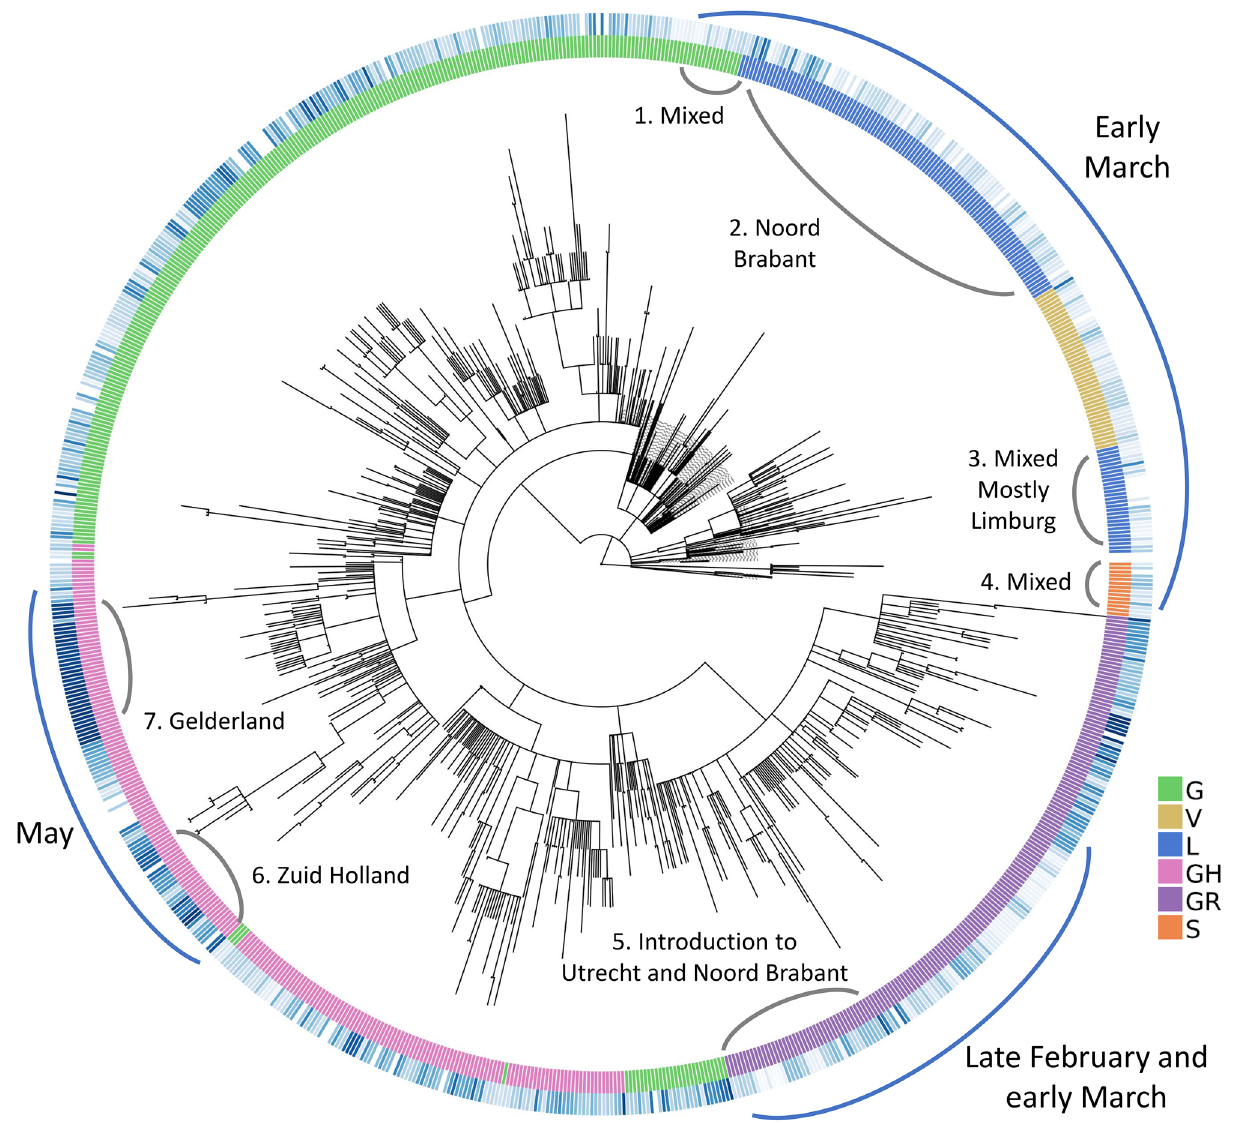
Figure 8. Radial representation of the Dutch phylogenetic tree: inner circle colored w.r.t. the assigned clades (see legend for clade names), outer circle is color-coded according to the sample collection date (if available), where the darker shade of blue represents more recent samples. Major points discussed in the text have been indicated with blue arches on the outer circle, along with more detailed information (numbered in clockwise direction) in gray arches on the inner